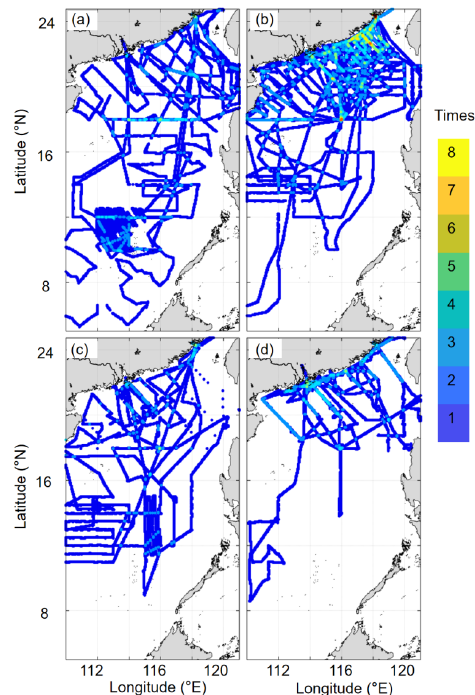
Figure 1. Frequency of sea surface salinity (SSS) in the South China Sea during four seasons from October 2003 to September 2020 (( a ). Spring; ( b ). Summer; ( c ). Fall; ( d ). Winter). To verify the reliability of the reconstructed data, we divided the observational un ‐ derway dataset into two subsets. One includes the data collected until February 2018, which were used in machine learning (named OB_A), and the other represents the data collected after February 2018, which were used as an independent dataset for validation (named OB_B). We also used station ‐ based observational SSS data and SOCAT (Surface Ocean CO 2 Atlas) underway SSS data as additional validation datasets. The station ‐ based observational data were collected using a conductivity, temperature, and depth (CTD) recorder during the same cruises shown in Table 1, and the mean salinity of the upper 5 m was taken as the SSS. The SOCAT underway SSS data available over 2001–2021 in the SCS were downloaded from the SOCAT website (https://www.socat.info, accessed on 30 August 2021).